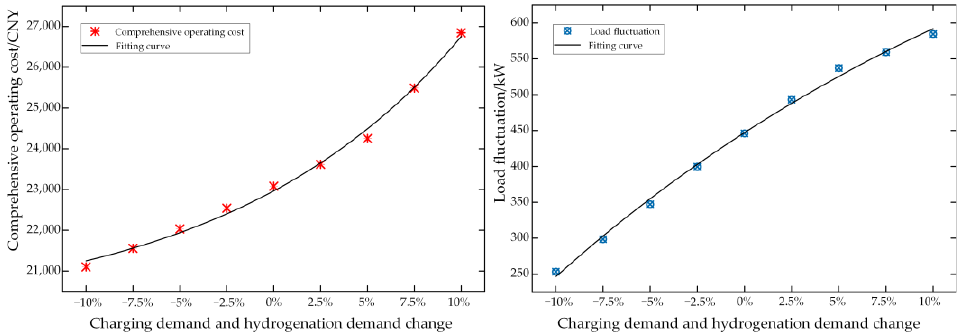
Figure 14. The impact of energy supply demand changes of −1 0% – 10% on operating results.